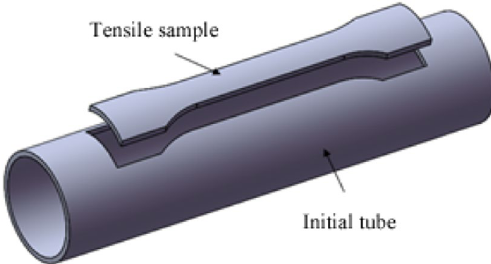
Figure 5 Schematic of tensile test cutting